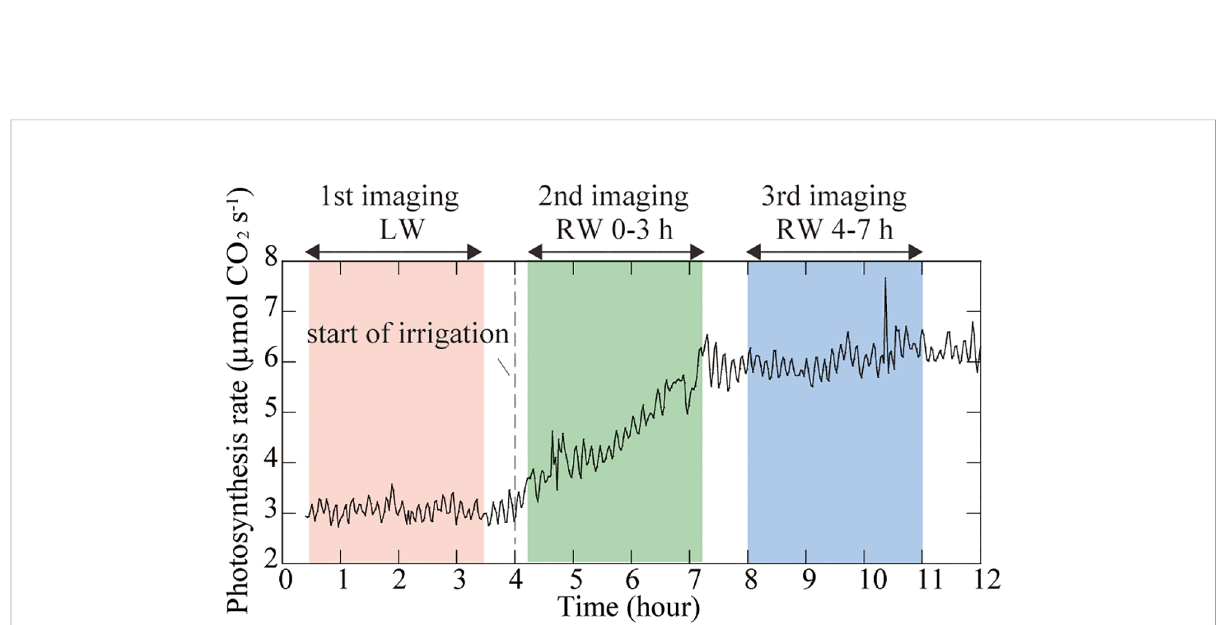
FIGURE 3 Time course of the photosynthesis rate of rice leaves during PETIS imaging. Zero hour indicates the start of the lighting period. The light pink area indicates the fi rst PETIS imaging under the low water content (LW), the light green area indicates the second PETIS imaging under the recover water content 0-3 h (RW 0-3 h), and the light blue area indicates the third PETIS imaging under the recover water content 4-7 h (RW 4- 7 h). Irrigation started 4 h after the start of the light period.